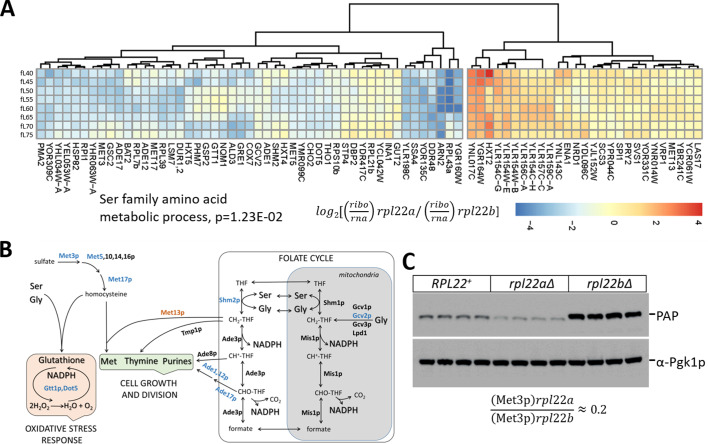
Reduced translational efficiency of transcripts encoding enzymes of the methionine and 1C metabolic pathways in rpl22aΔ cells.(A) Heatmap of the transcripts with significantly different translational efficiencies (see Figure 3) between the two Rpl22 paralog deletion strains. The ratio of the TPM values for the ribosome footprints ((ribo) against the corresponding values for the mRNA reads (rna) define the translational efficiency of each locus in each paralog mutant. The data were hierarchically clustered and displayed with the pheatmap R package. Each row corresponds to a separate cell size interval, from 40 to 75 fL, from top to bottom. The Gene Ontology terms highlighted were enriched, based on the PANTHER platform classification, incorporating the Holm-Bonferroni correction. (B) Diagram of the metabolic pathways involving enzymes whose mRNAs have altered translational efficiency in rpl22aΔ vs rpl22bΔ cells. Proteins whose mRNAs have lower translational efficiency in rpl22aΔ cells are shown in blue. (C) Immunoblots from WT (RPL22+), rpl22aΔ, or rpl22bΔ cells, carrying a MET3-TAP allele expressed from its endogenous chromosomal location. All the strains were otherwise isogenic. The signal corresponding to Met3p-TAP was detected with the PAP reagent, while the Pgk1p signal represents loading. The band intensities were quantified using the ImageJ software package, and the relative abundance of Met3p-TAP in rpl22aΔ: rpl22bΔ cells is shown at the bottom, from three independent such experiments.Figure 5—source data 1.mRNAs with significantly different translational efficiency between any two strains.